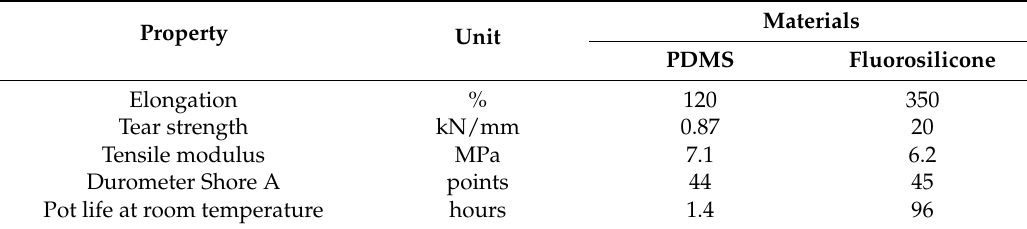
Table 1. Comparison of Sylgard-184 and 5-8601